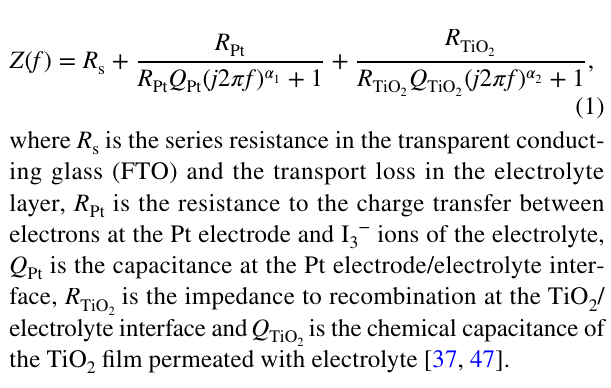
Fig. 4 a Equivalent circuit model used for fitting Nyquist plots. Nyquist plots generated from equivalent circuit model fit with measured data for b chlorophyll, c betanin and d betanin–chlorophyll solar